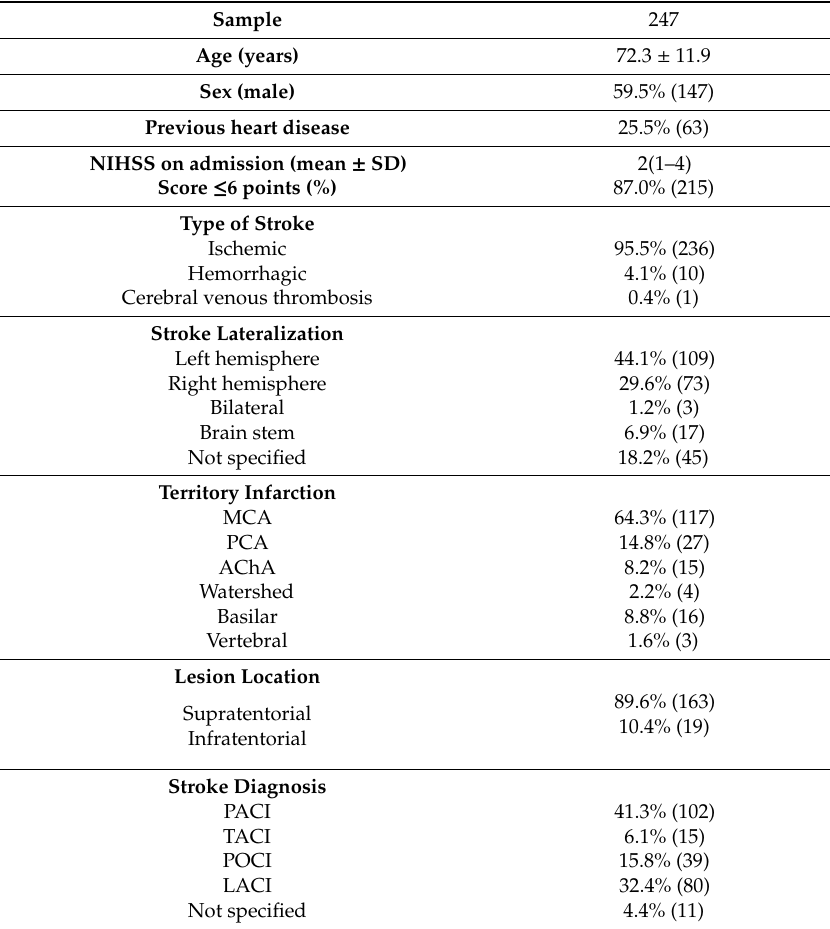
Table 1. Demographic, clinical, and nutritional characteristics of post-stroke patients on admission and at 3-month follow